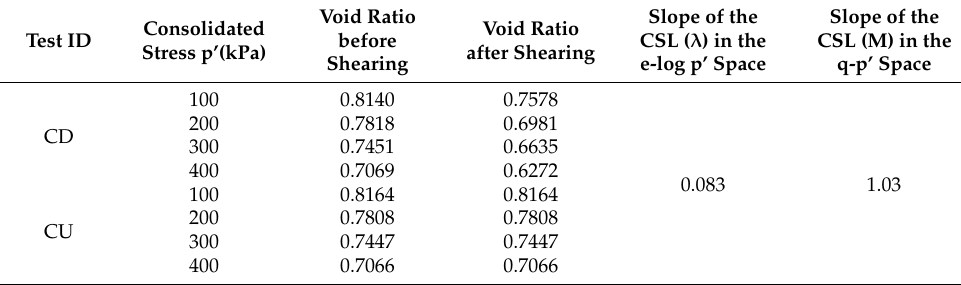
Table 4. Testing conditions of the drained and undrained shearing tests of the disturbed